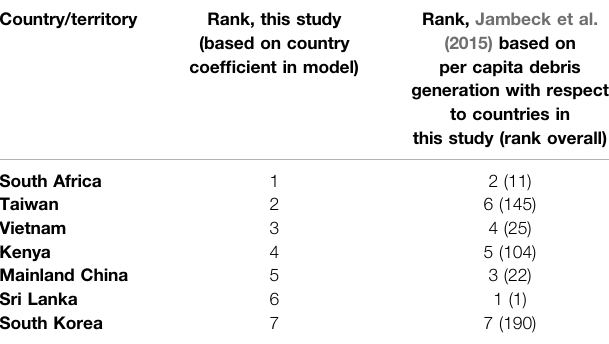
TABLE 5 | Relative rankings of countries surveyed in this study as compared to relative rankings in Jambeck et al. (2015). Highest debris load = 1, lowest = 7. Country/territory Rank, this study Rank, Jambeck et al. (based on country (2015) based on coef fi cient in model) per capita debris generation with respect to countries in this study (rank